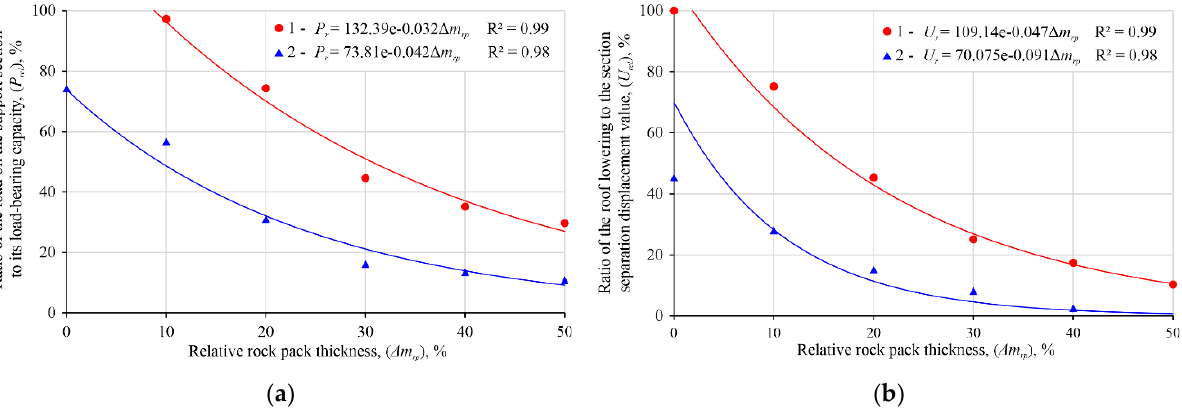
Figure 8. Dependence of a change in the maximum stress concentrations of rock layers in the destressing zone on the relative rock pack thickness: ( a ) Force characteristics of powered support; ( b ) Deformation characteristics of powered support; 1—unfavorable conditions; 2—favorable con ‐ ditions